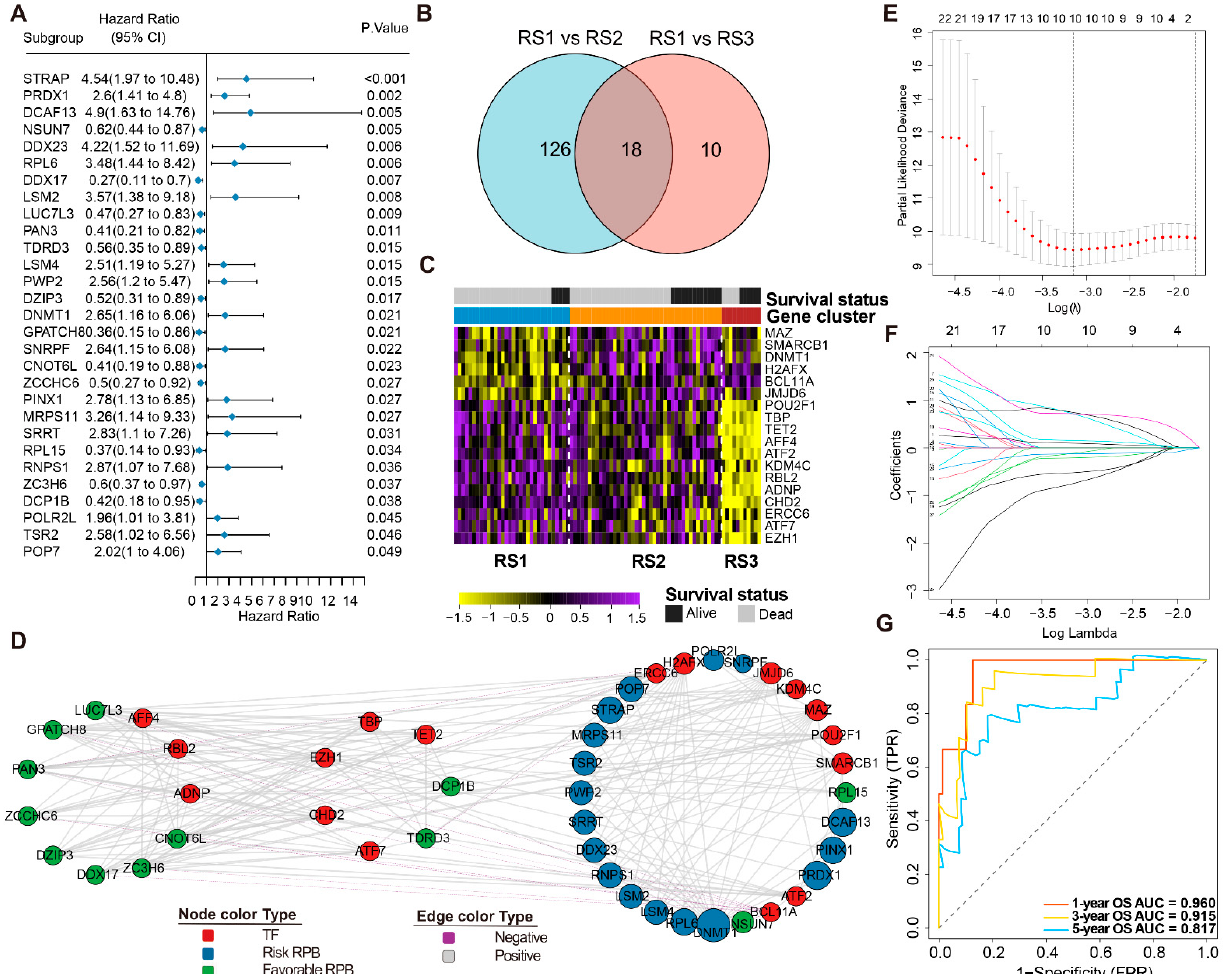
Figure 3. RBP regulatory network and prognostic risk model ( A ). Univariate analyses of 29 significant DERBPs with overall survival ( p < 0.05). ( B ) Abundances of 18 DETFs (identified in dead ES patients) in the three RSs. ( C ) Overlap of DETFs between RS1 versus RS2 and RS1 versus RS3. ( D ). DERBPs network in ES. Circles represents all genes. Red indicates TF; blue indicates high risk RBP; and green indicates low risk RBP. The size of each circle indicates the degree of correlation. Grey lines indicate positive correlations, and purple lines indicate negative correlations (r > 0.4, p < 0.01). ( E ). Partial likelihood deviance under each log (lambda) was drawn in a LASSO Cox regression model. ( F ). The change trajectory of each independent variable in the model. ( G ). ROC curve of the prognostic values of the RPRM risk model in training group in 1-, 3- and 5-year OS.